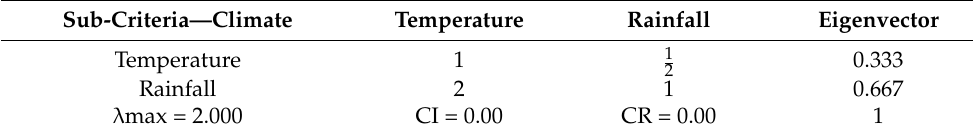
Table 4. Pair-wise comparison matrix of the sub-criteria for climate.